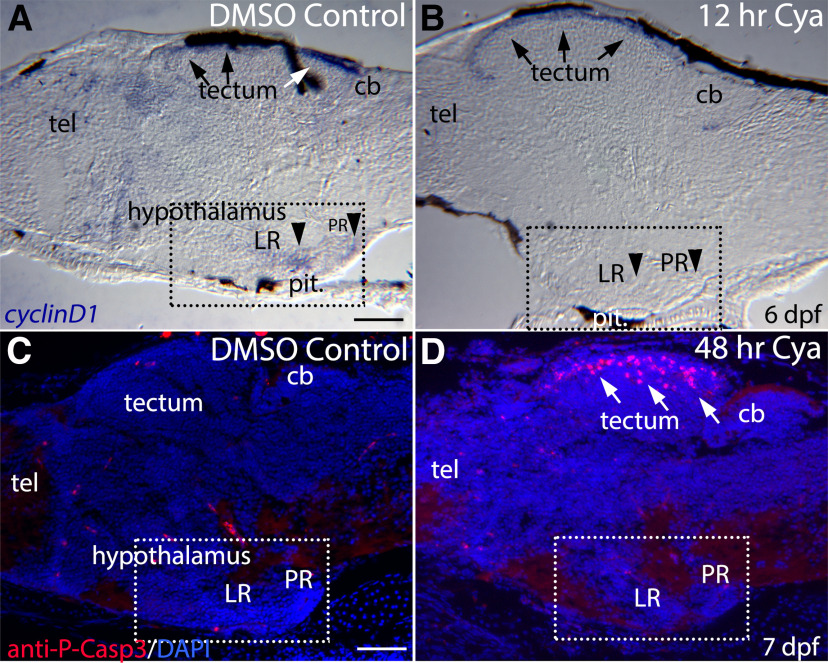
Blocking Hh signaling with Cya reduces cyclinD1 expression in the hypothalamus but does not increase hypothalamic cell death. A, Sagittal section through a 6-dpf larval brain showing cyclinD1 mRNA expression in the ventricular regions of the hypothalamus (dashed-square), telencephalon (tel), and dorsal tectum (arrows). B, cyclinD1 is expression is eliminated in the LR and PR of the hypothalamus (arrowheads) following 12 h of Cya exposure but is largely unaffected in the tectum (arrows). C, Cell death in a DMSO-treated control larva as revealed by anti-phospho-Caspase3 antibody labeling. D, Two-day Cya treatment did not lead to increased cell death in the hypothalamus, although increased cell death was seen in the tectum (arrows). cb, cerebellum; tect, tectum; tel, telencephalon. Scale bars: 50 μm.